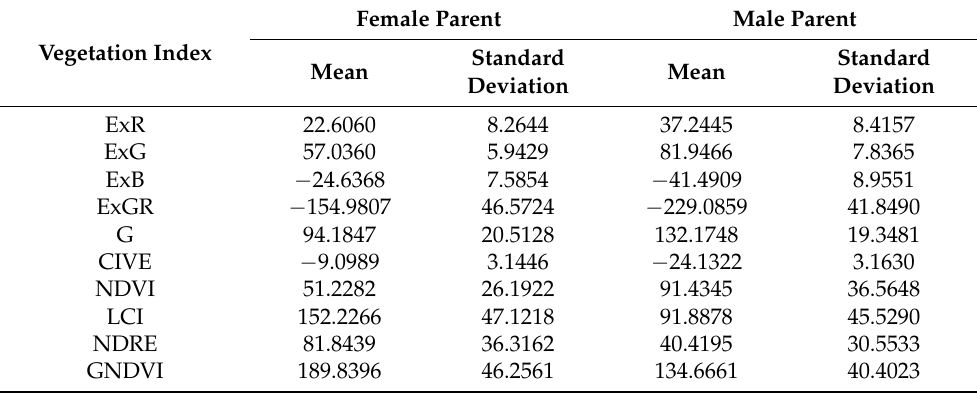
Figure 4. Calculation results for four kinds of multispectral vegetation indices. Table 3. Statistics for six visible light vegetation indices based on region of